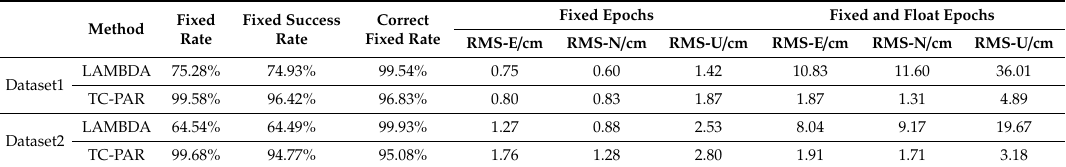
Table 4. Static experiment results of LAMBDA and TC-PAR.